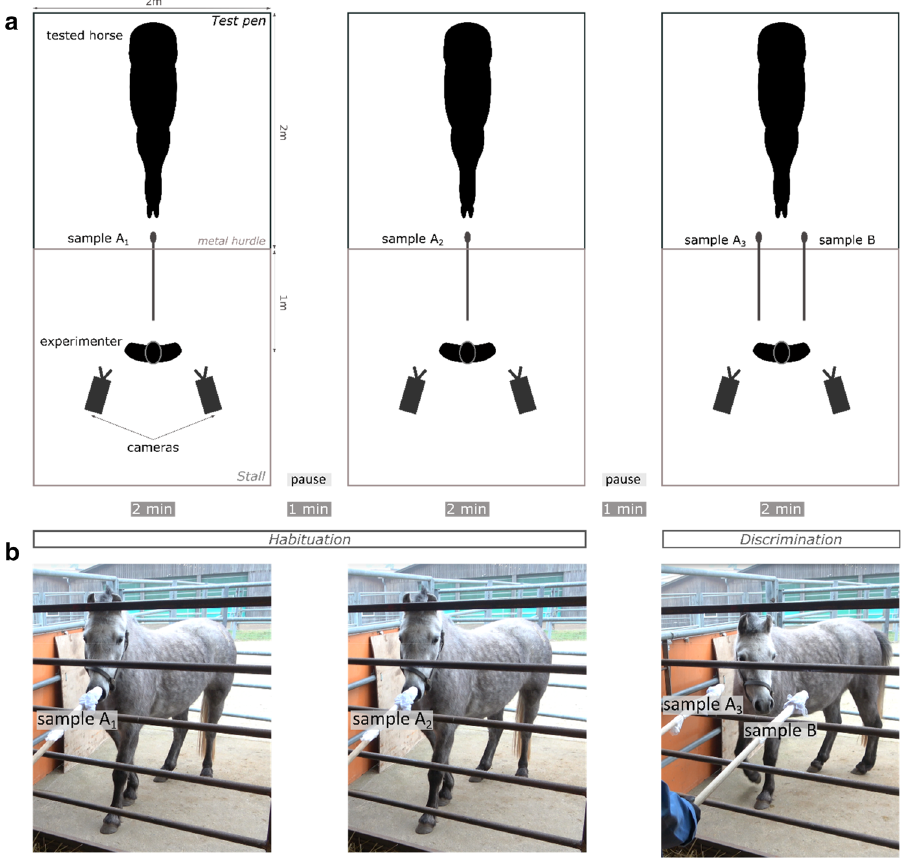
Figure 1. Habituation–discrimination protocol. ( a ) Schematic representation of the experimental set-up. ( b ) Photographs showing sample presentation. Photograph courtesy of Plotine